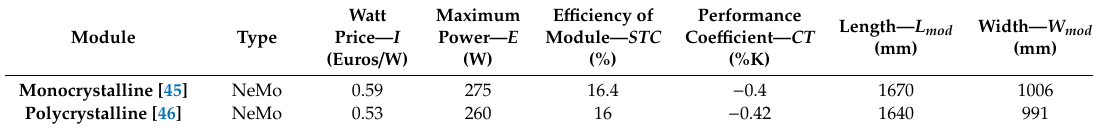
Table 2. Specifications of the PV